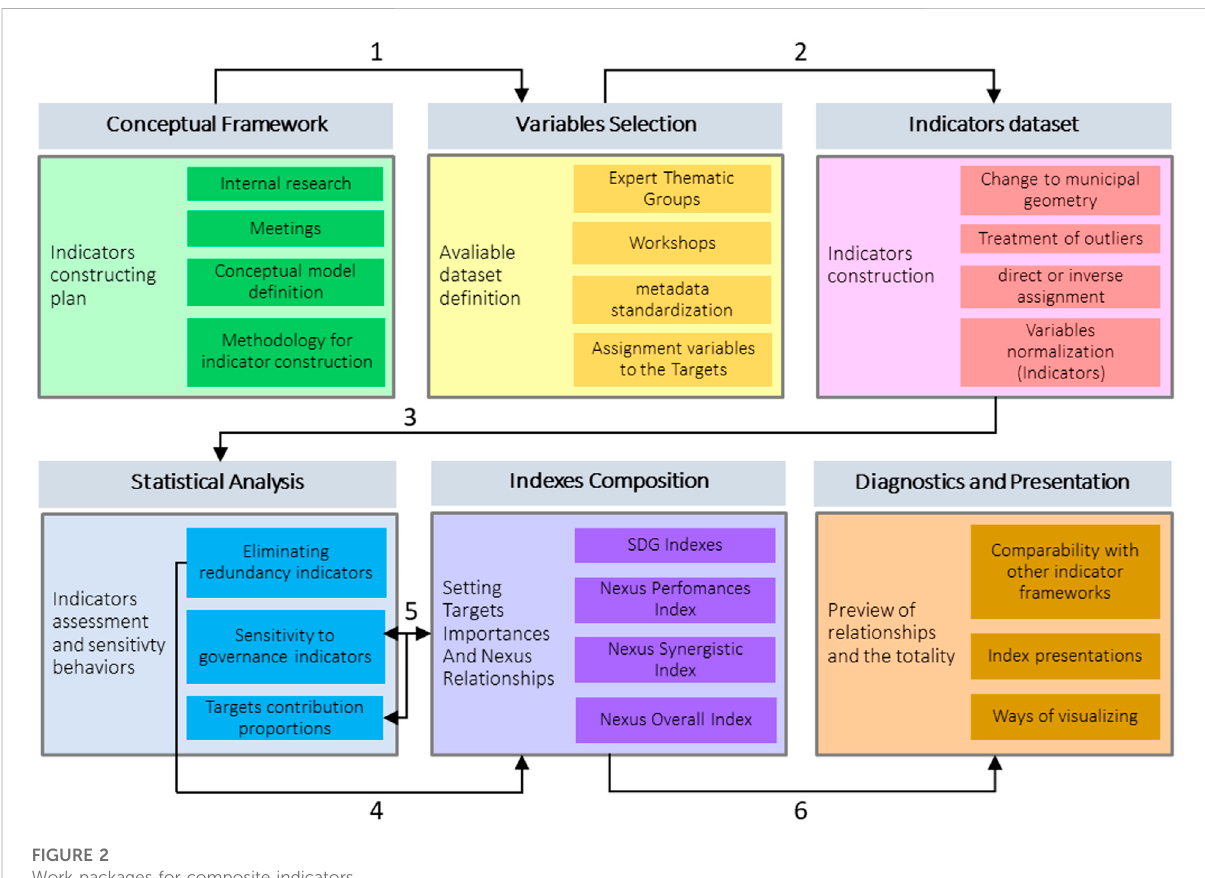
FIGURE 2 Work packages for composite